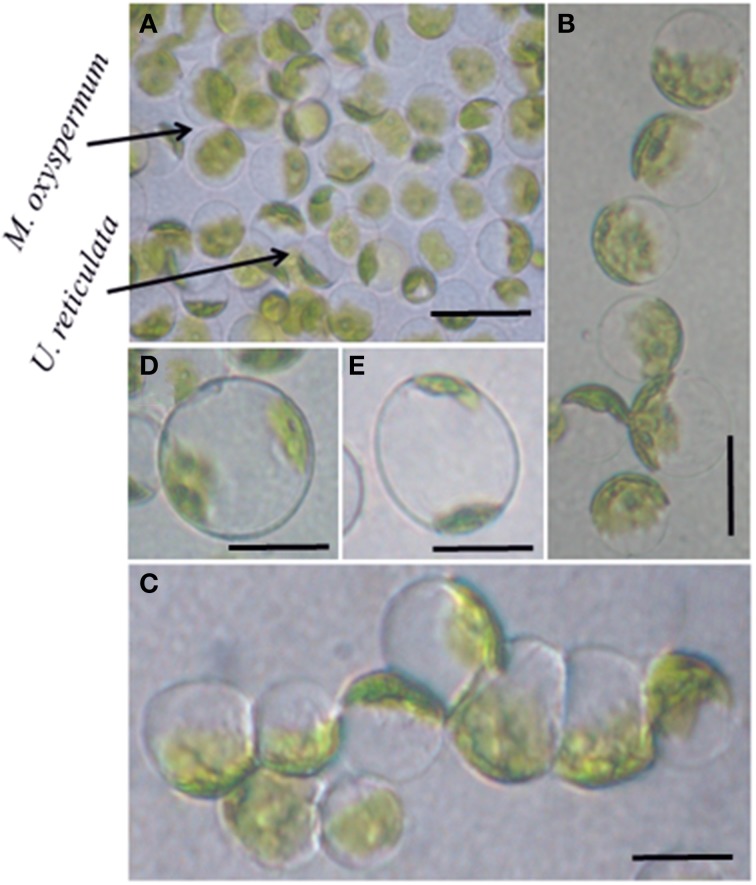
Protoplast fusion between the selected species M. oxyspermum and U. reticulata. (A) Mixture of protoplasts isolated from the selected species, (B,C) protoplasts alignment and pearl-chain formation after applying AC pulse, (D,E) protoplast fusion after applying DC pulse showing two chloroplasts in a single cell. Scale bar = 50 μm.